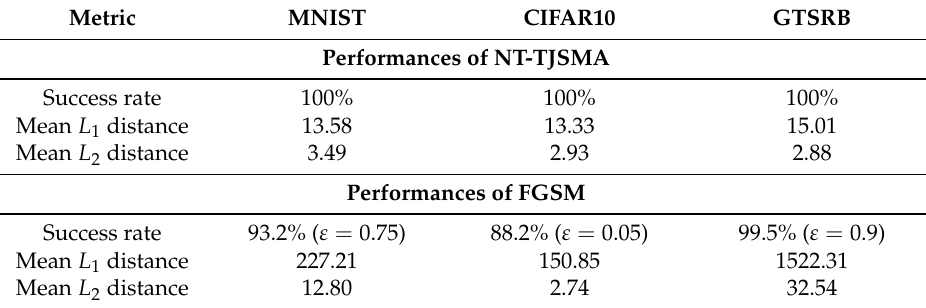
Table 8. Comparison between NT-TJSMA and